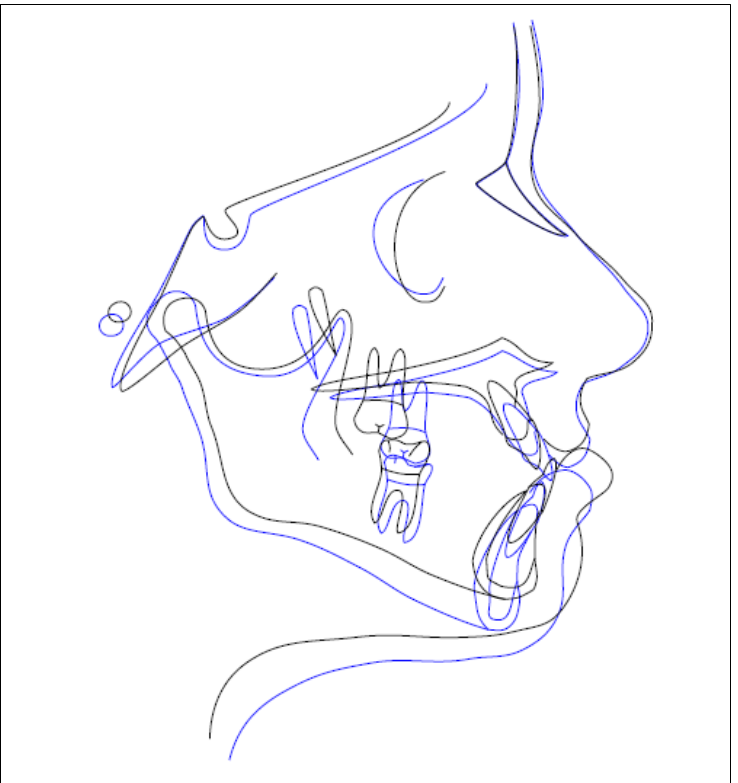
Figure 13. Superimposed pre-treatment (black line) and post-treatment (blue line) cephalometric tracings.